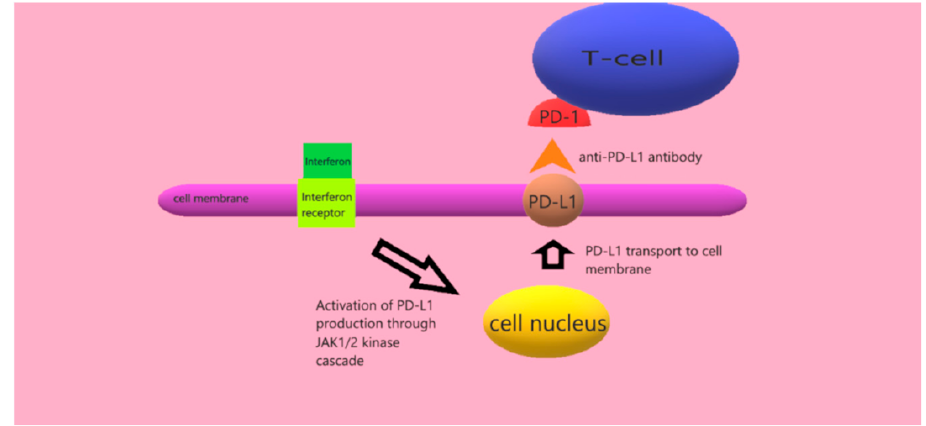
Figure 2. Effect of anti-PD-L1